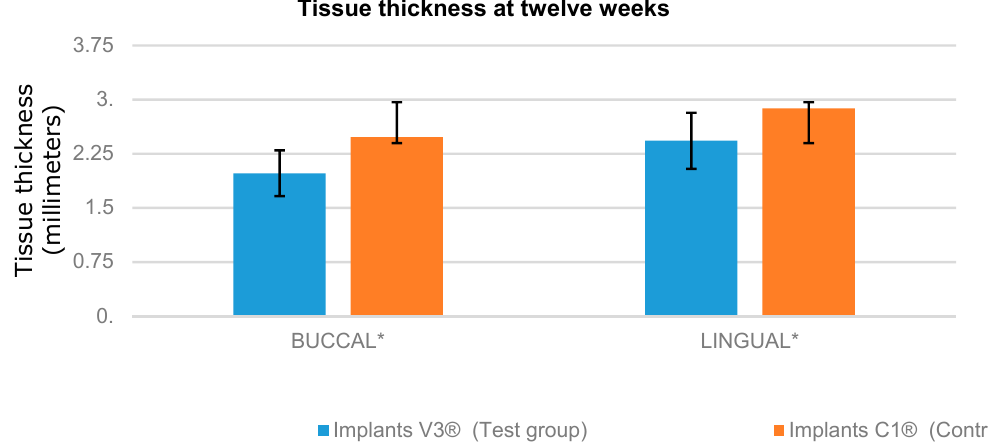
Figure 6. Tissue thickness changes between baseline and 12-week study times. Tissue thickness loss (mean ± SD); * indicates significant differences ( p < 0.05). Table 2. Bone-level changes between baseline and 12-week study times (measured from the top of the implant collar (line IS) to the first point of bone-to-implant contact (line C)). Marginal bone loss (mean ± SD); * indicates significant differences ( p < 0.05).